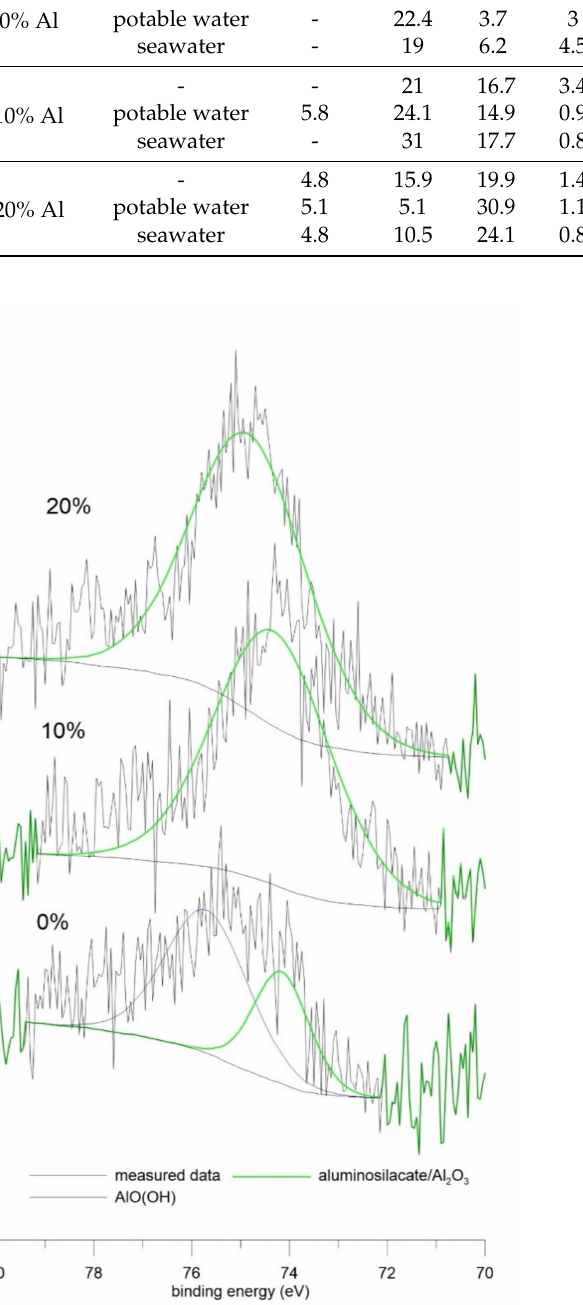
Figure 1. Detail of the XPS spectra of tested alloys—the original surface before the